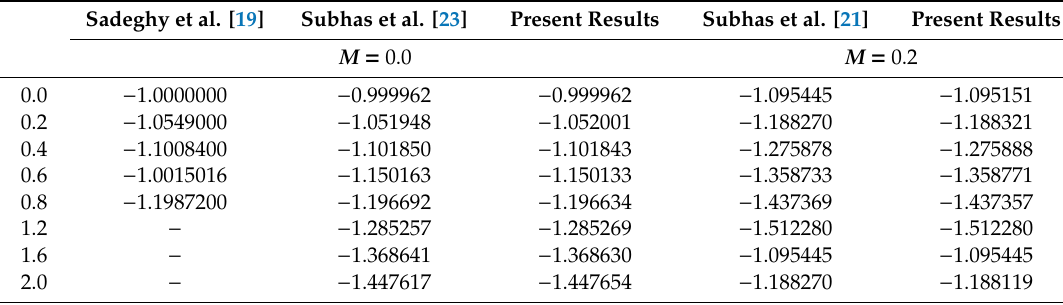
Table 1. Comparison of f (cid:48)(cid:48) ( 0 ) for various values of β and M when λ = 0 and ξ = 1. Sadeghy et al. [19] Subhas et al. [23] Present Results Subhas et al. [21] Present Results M =